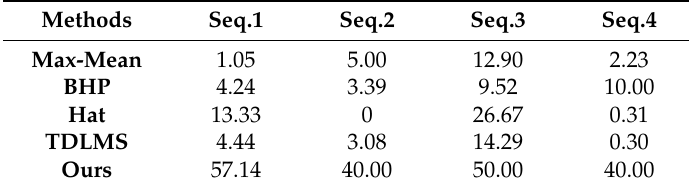
Figure 9. Original results of in-frame detection generated by four state-of-the-art algorithms: ( a ) Raw IR images; ( b ) Max-mean; ( c ) Butterworth high-pass (BHP) ( d ) Hat; ( e ) Two-dimensional least mean square (TDLMS). Table 2. Statistical results of η (%) for the in-frame